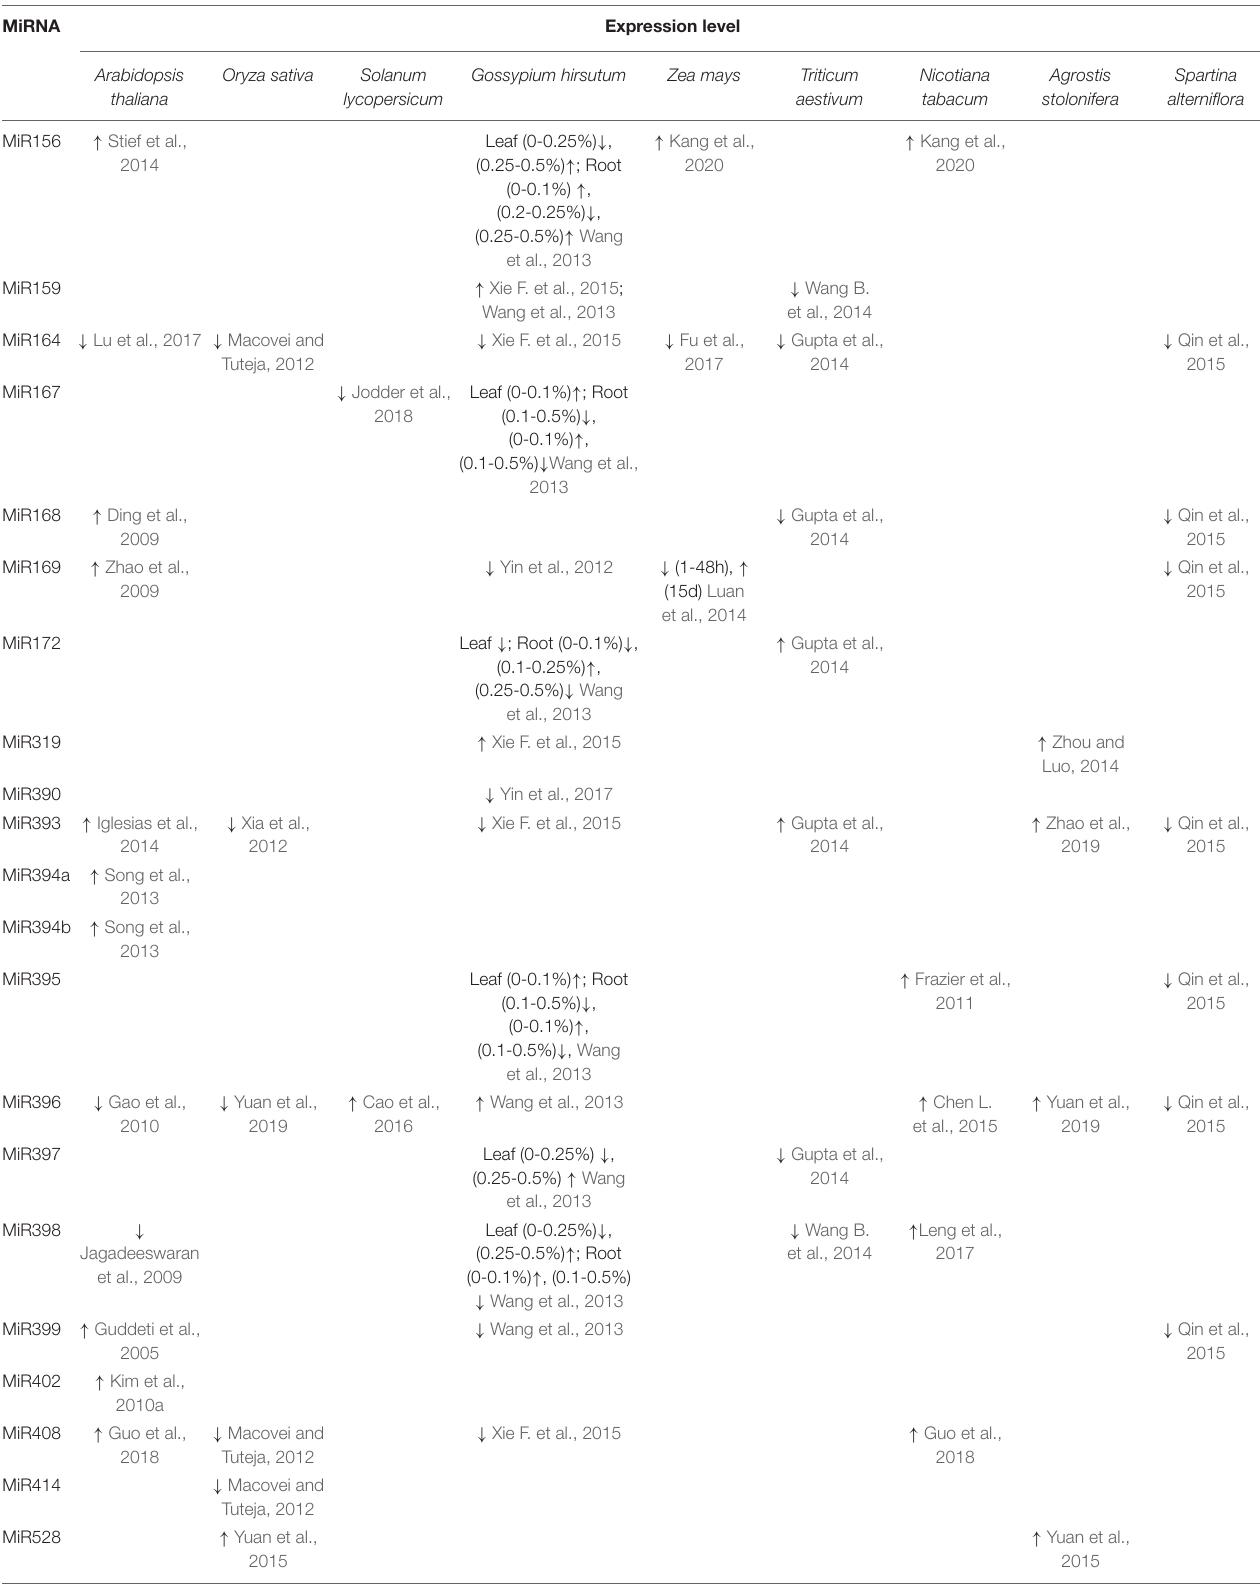
TABLE 2 | The expression of representative plant miRNAs under salt stress. MiRNA Expression level Arabidopsis Oryza sativa Solanum thaliana